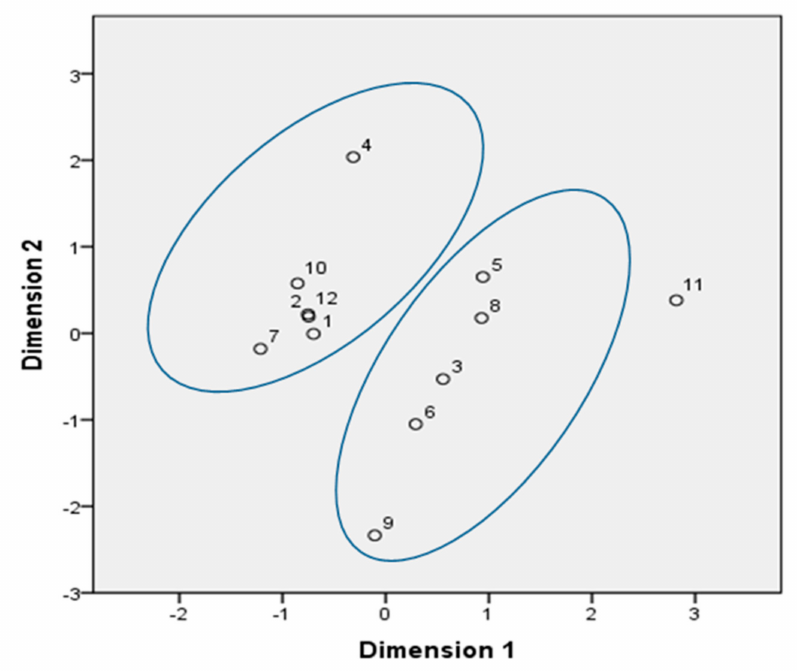
Figure 1. Multiple correspondence analysis of all samples based on the function of their studied